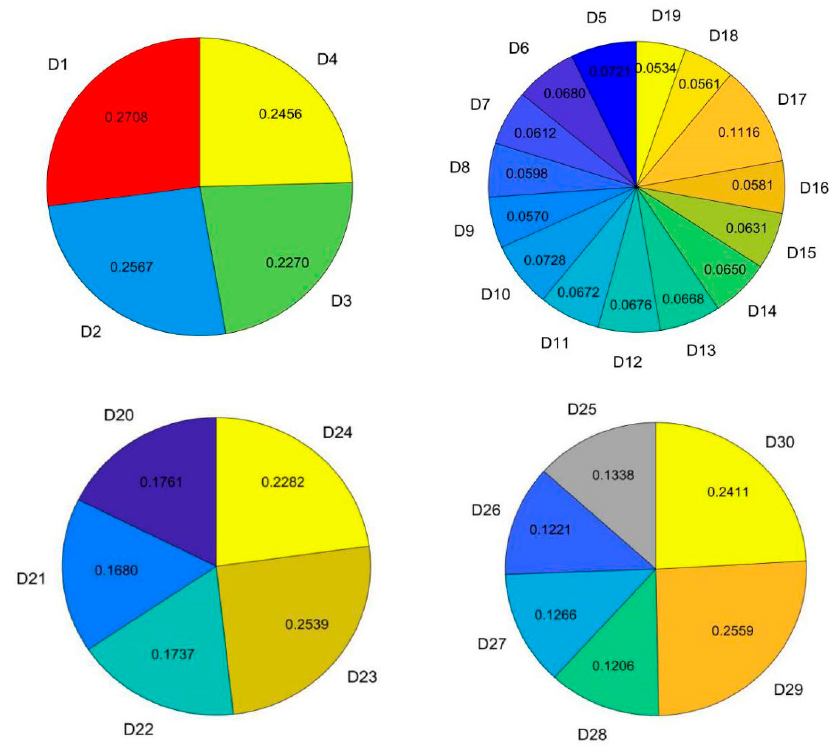
Figure 3. The total weight of evaluation